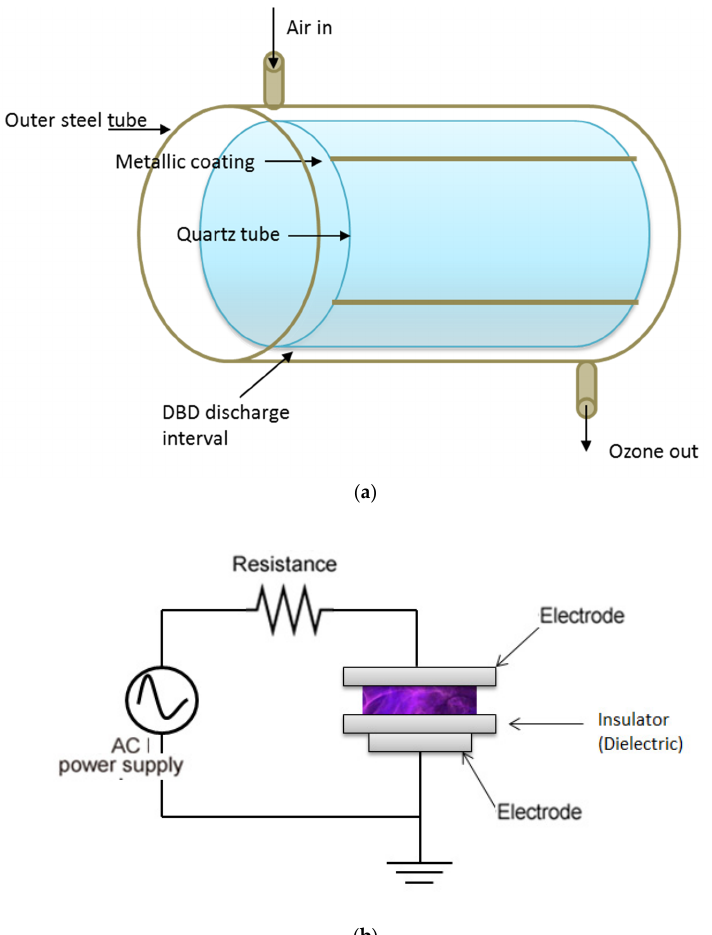
Figure 1. Typical configuration of a DBD reactor: ( a ) cylindrical configuration and ( b ) plate electrode configuration .